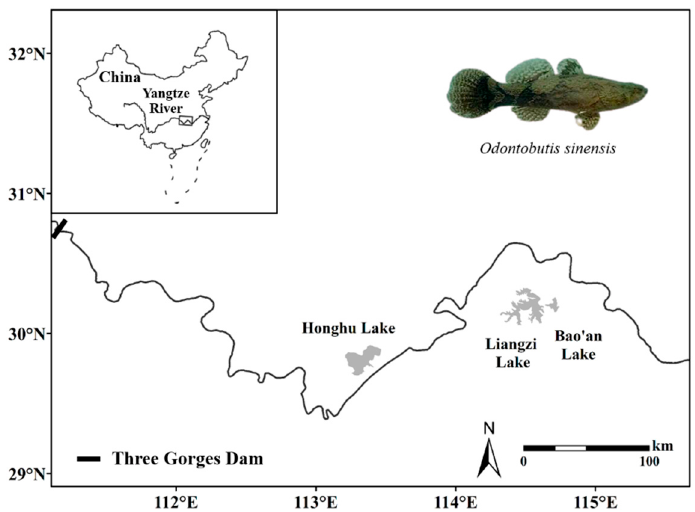
Figure 1. Map of the middle Yangtze River, China, showing the locations of Honghu Lake (the present-day studied population) and Bao’an Lake and Liangzi Lake (the two historical populations) where life-history traits of Odontobutis sinensis were compared.